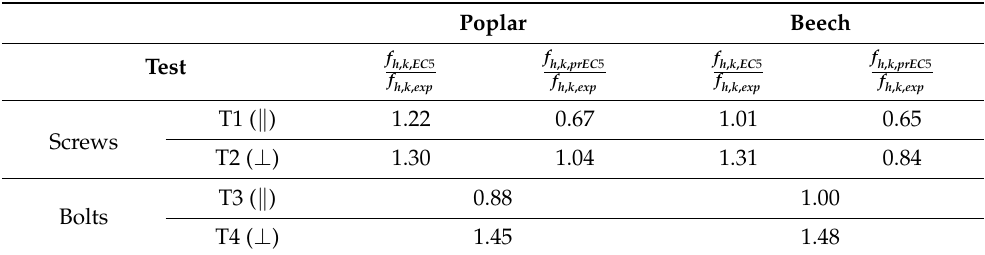
Table 4. Ratios between theoretical values of embedment strength according to EC5 and prEC5 and experiment values according to ASTM D